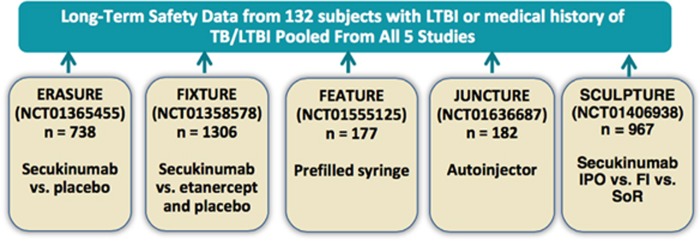
Safety data were pooled from five phase 3 studies of secukinumab in patients with moderate to severe plaque psoriasis. FI, fixed-interval; IPO, induction-period only; SoR, start of relapse.